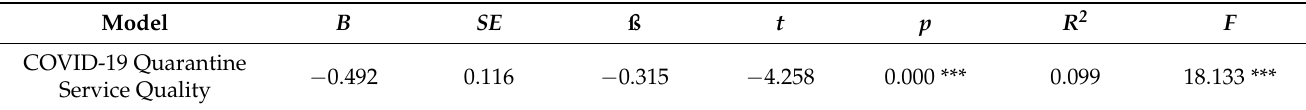
Table 8. Results of multiple regression using COVID-19 quarantine service quality to predict switch- ing